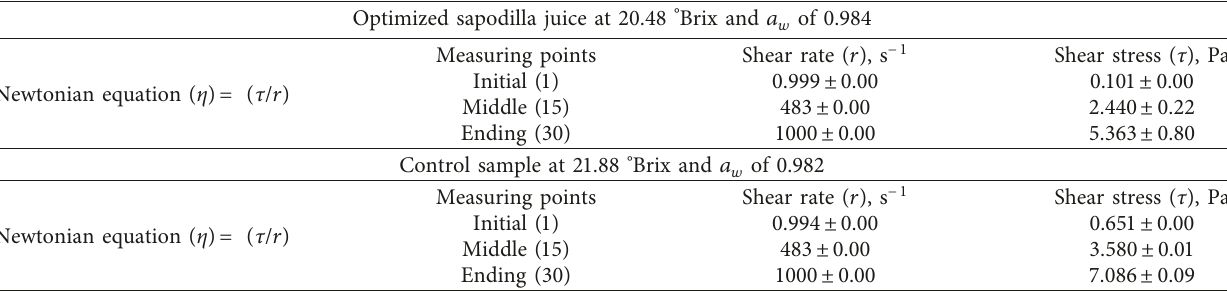
Figure 8: The rheogram of enzyme-optimized juice and control juice at specific TSS and water activity at 25 ° C. Table 6: Shear stress-stress rate data of optimized juice and control juice at major points.